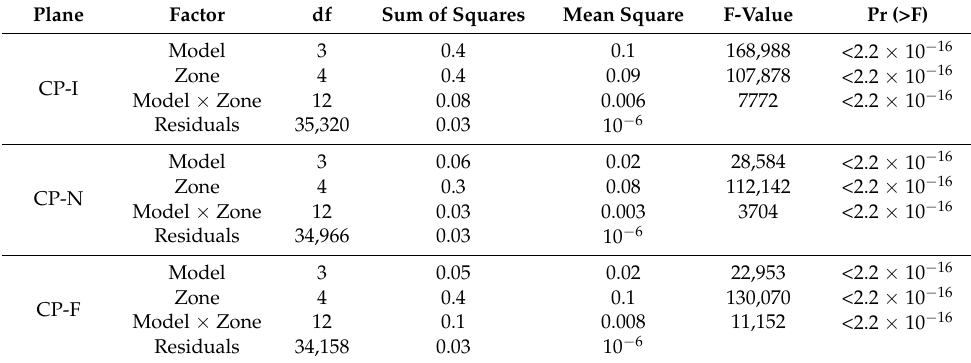
Table 1. Analysis of variance (ANOVA) of mass fractions of virus particles from five bird-occupied zones at three cross-sectional reference planes (CP-I, CP-N, and CP-F) in four models. Plane